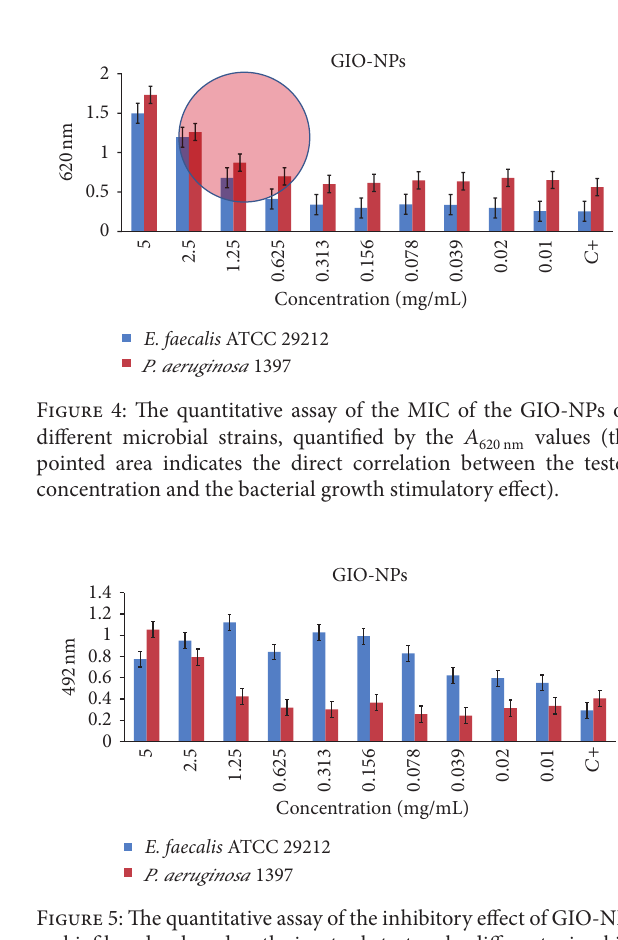
F 5: e quantitative assay of the inhibitory effect of GIO-NPs onbio�lmsdevelopedontheinertsubstratumbydifferentmicrobial strains� quanti�ed by the nm 𝐴𝐴 490